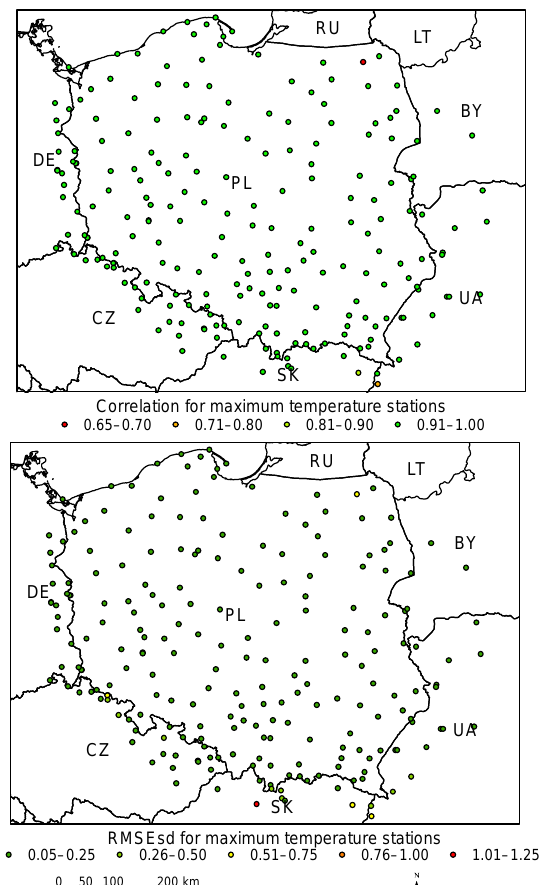
Figure 9. Maximum temperature ρ (top) and RMSEsd (bottom) values calculated for stations in the period 1951–2013. National borders (black lines) are labelled with country codes.